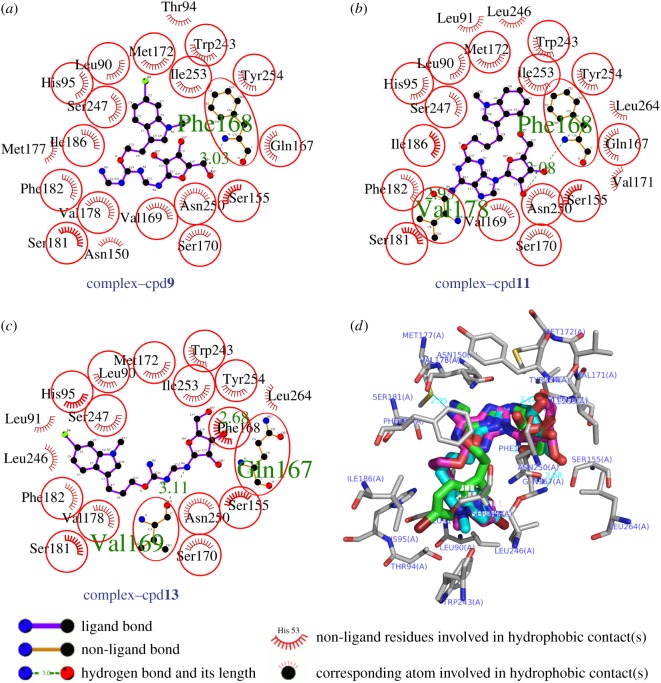
The two-dimensional image of ligand–hA3AR interactions with the hydrogen bonds and hydrophobic interactions (a–c); (d) the cpd9 is coloured green, the cpd11 is coloured magenta, the cpd13 is coloured cyan, respectively. The surrounding residues interacting with these ligands are also shown and labelled. The meaning of the items on the two-dimensional plot above is listed in the bottom panel.